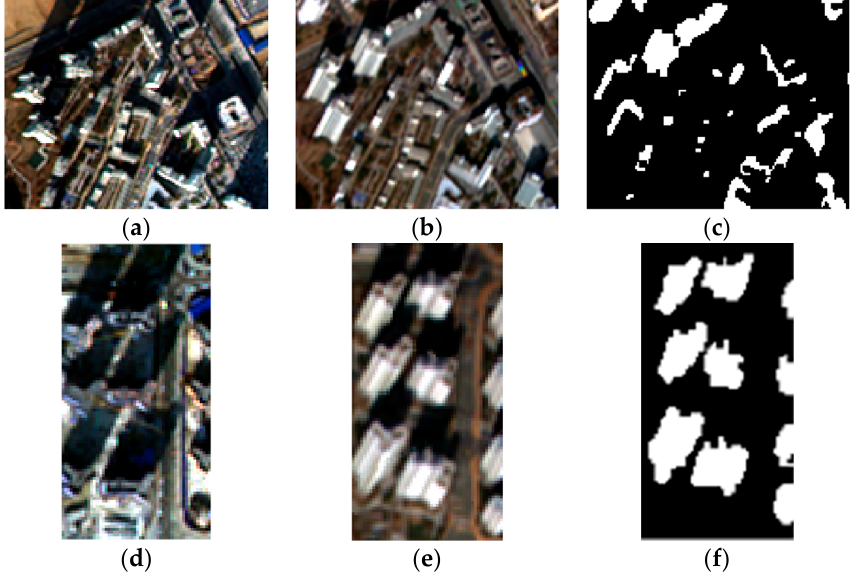
Figure 12. Examples of false alarms in experiment 1 ( a – c ) and experiment 2 ( d – f ), ( a ) image T1 of the first subset, ( b ) image T2 of the first subset, ( c ) the result of the first subset by the proposed method, ( d ) image T1 of the second subset, ( e ) image T2 of the second subset, and ( f ) the result of the second subset by the proposed method.